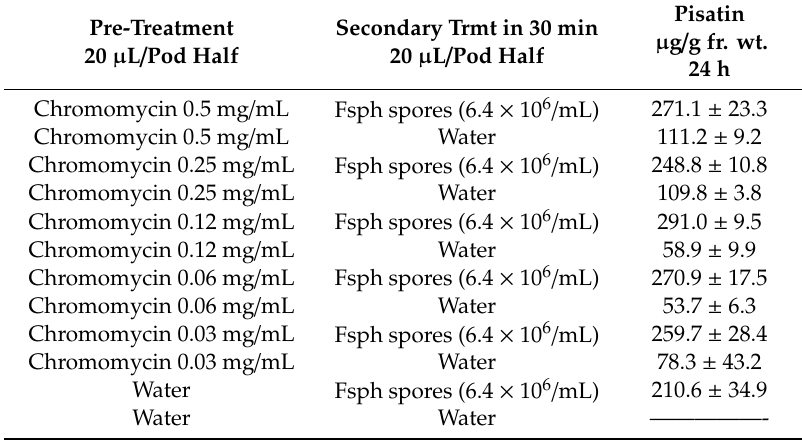
Table 5. Chromomycin concentrations were compared with and without a constant concentration of Fsph spores as elicitors of pisatin. All treatments were in volumes of 20 µ L / pod half.